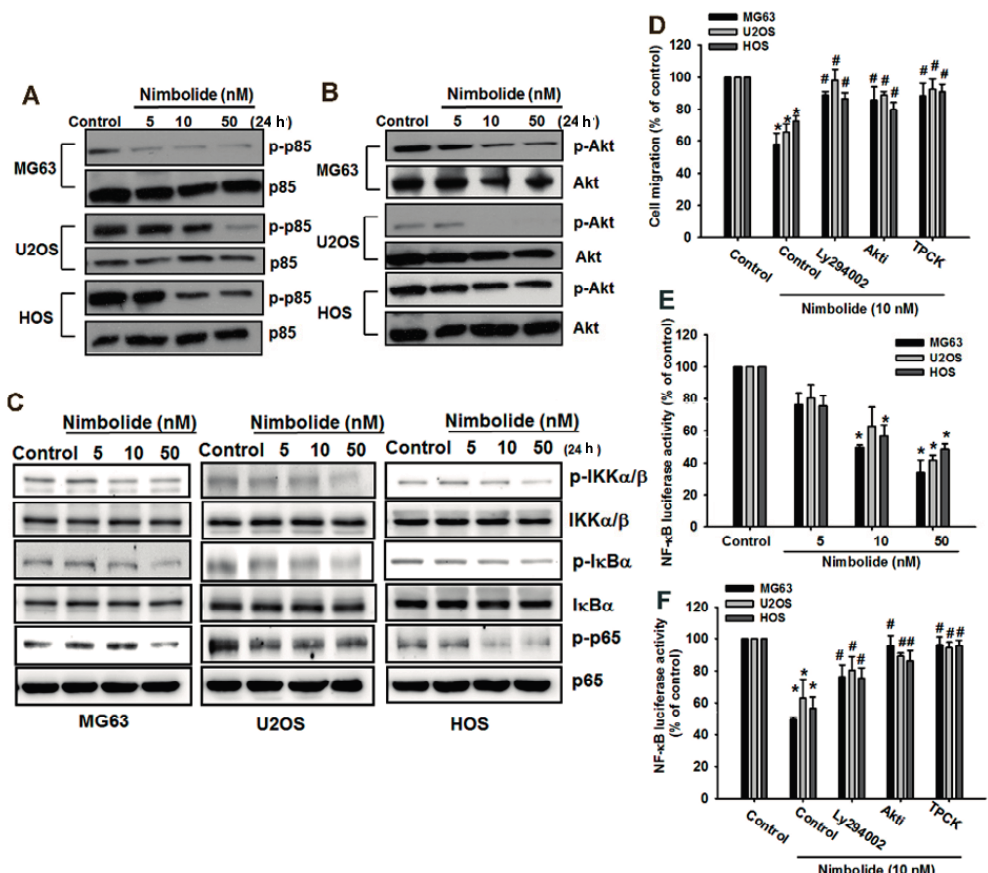
Figure 6. PI3K/Akt and NF- κ B pathways function downstream of Nimbolide to inhibit cell migration in human osteosarcoma cells. ( A – C ) Osteosarcoma cells (MG63, U2OS, and HOS) were treated with control solution or various concentrations of Nimbolide for 24